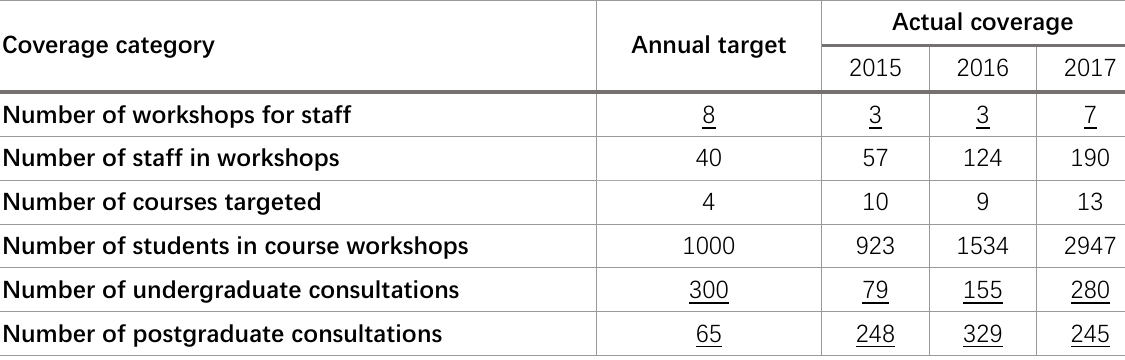
Table 1 : The Writing Lab’s annual coverage targets and actual coverage (2015 to